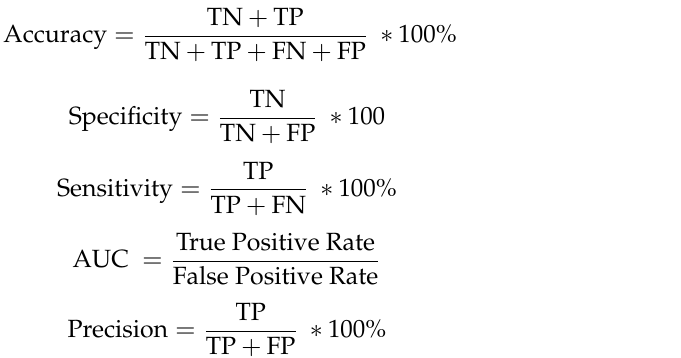
Testing Phase (20%)